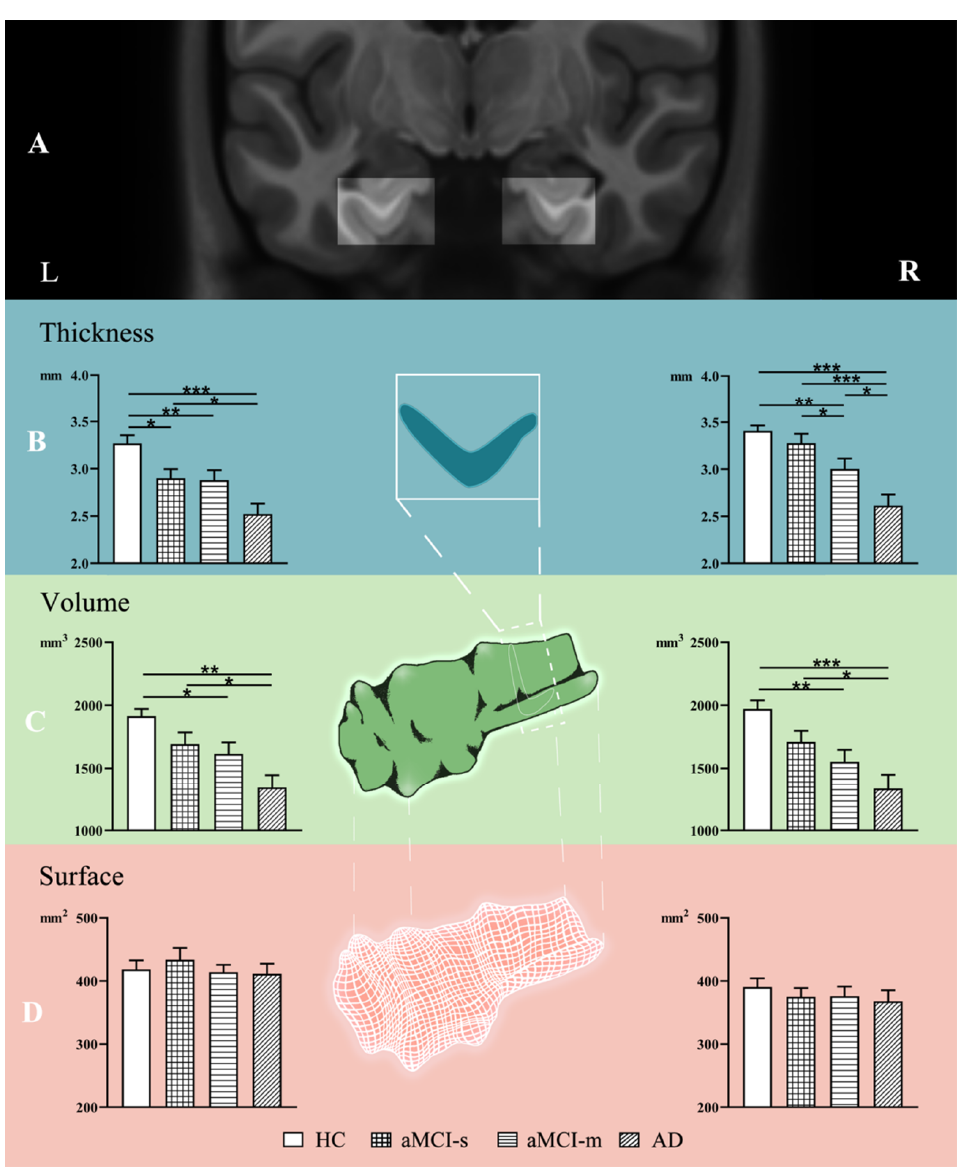
Figure 1. Alterations of ERC thickness, volume and surface area among HC, aMCI-s, aMCI-m and AD groups. The ERC location of left and right hemispheres in coronal slices ( A ). The figure shows group differences in ERC thickness ( B ), volume ( C ) and surface area ( D ). * p < 0.05; ** p < 0.01; *** p < 0.001. L: left, R: right.